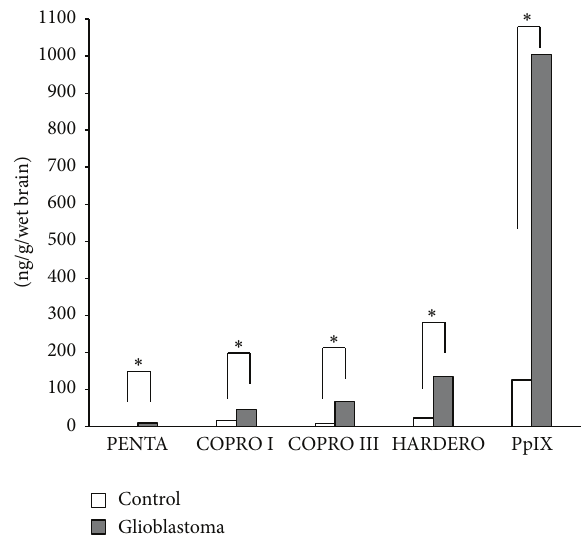
Figure 2: The amount of porphyrins in the control brain tissue and glioblastoma tissue. The white bar shows control tissue from a brain tumor patient ( 𝑛 = 14 ), and the gray bar shows glioblastoma ( 𝑛 = 28 ) ( ∗ 𝑝 < 0.05 ) (PENTA: pentacarboxyl porphyrin, COPRO I or III: coproporphyrin I or III, HARDERO: harderoporphyrin, and PpIX: protoporphyrin